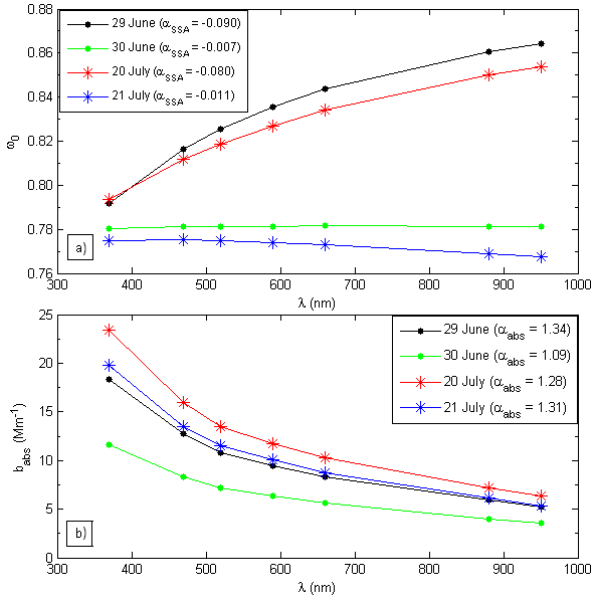
Figure 9. Spectral dependence of daily averaged (a) ω 0 and (b) b abs for 29 June (black), 30 June (green), 20 July (red), and 21 July (blue).